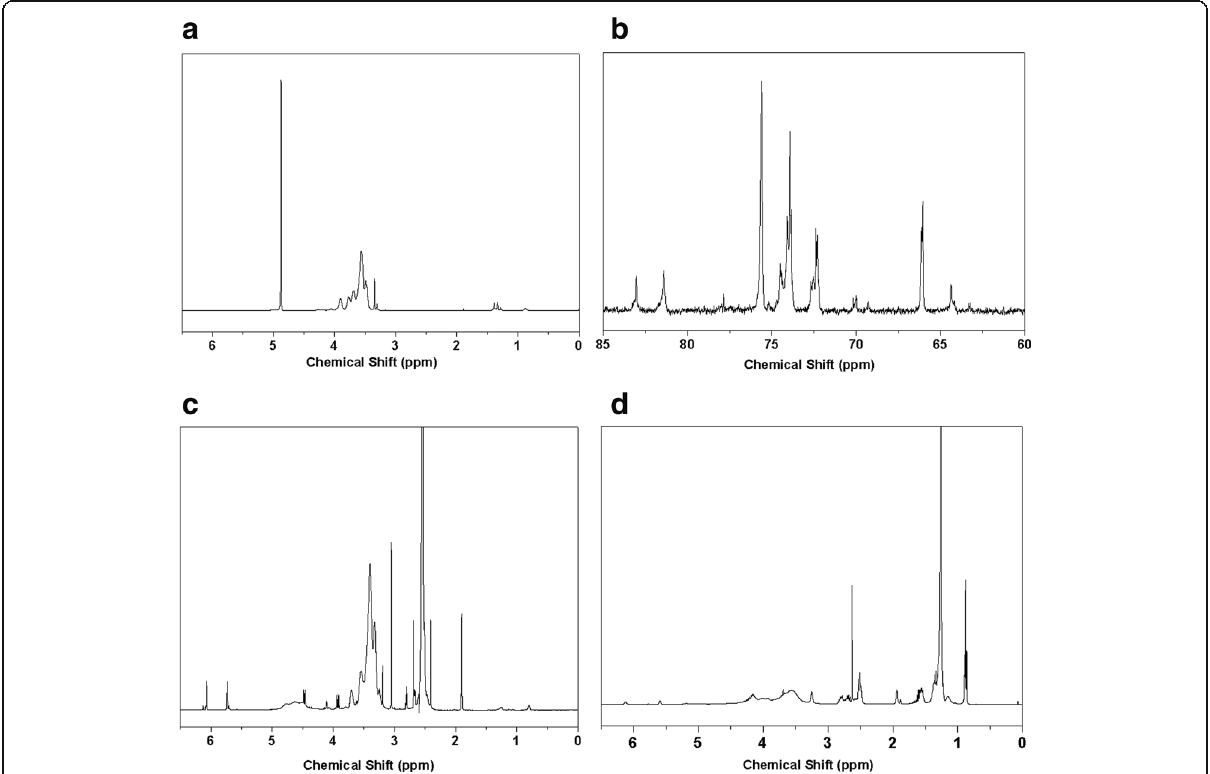
Fig. 1 NMR characterizations of HPG, HPG-MA, and DSHPG a 1 H NMR spectrum of HPG, b 13 C NMR spectrum of HPG, c 1 H NMR spectrum of